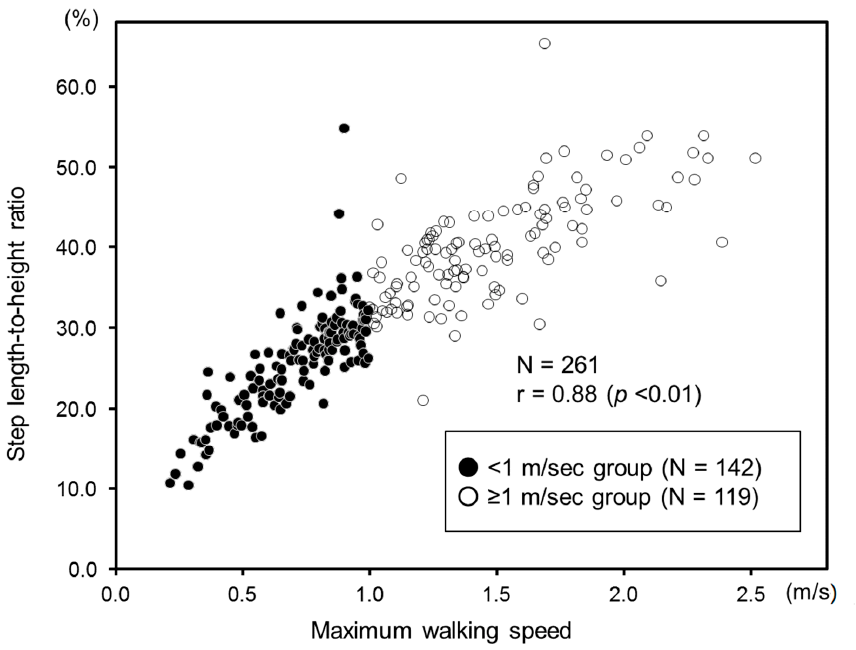
Figure 2 Relationship between the step length-to-height ratio and maximum walking speed. Step length-to-height ratio: Step length (cm)/height length-to-height ratio: Step length (cm)/height (cm).